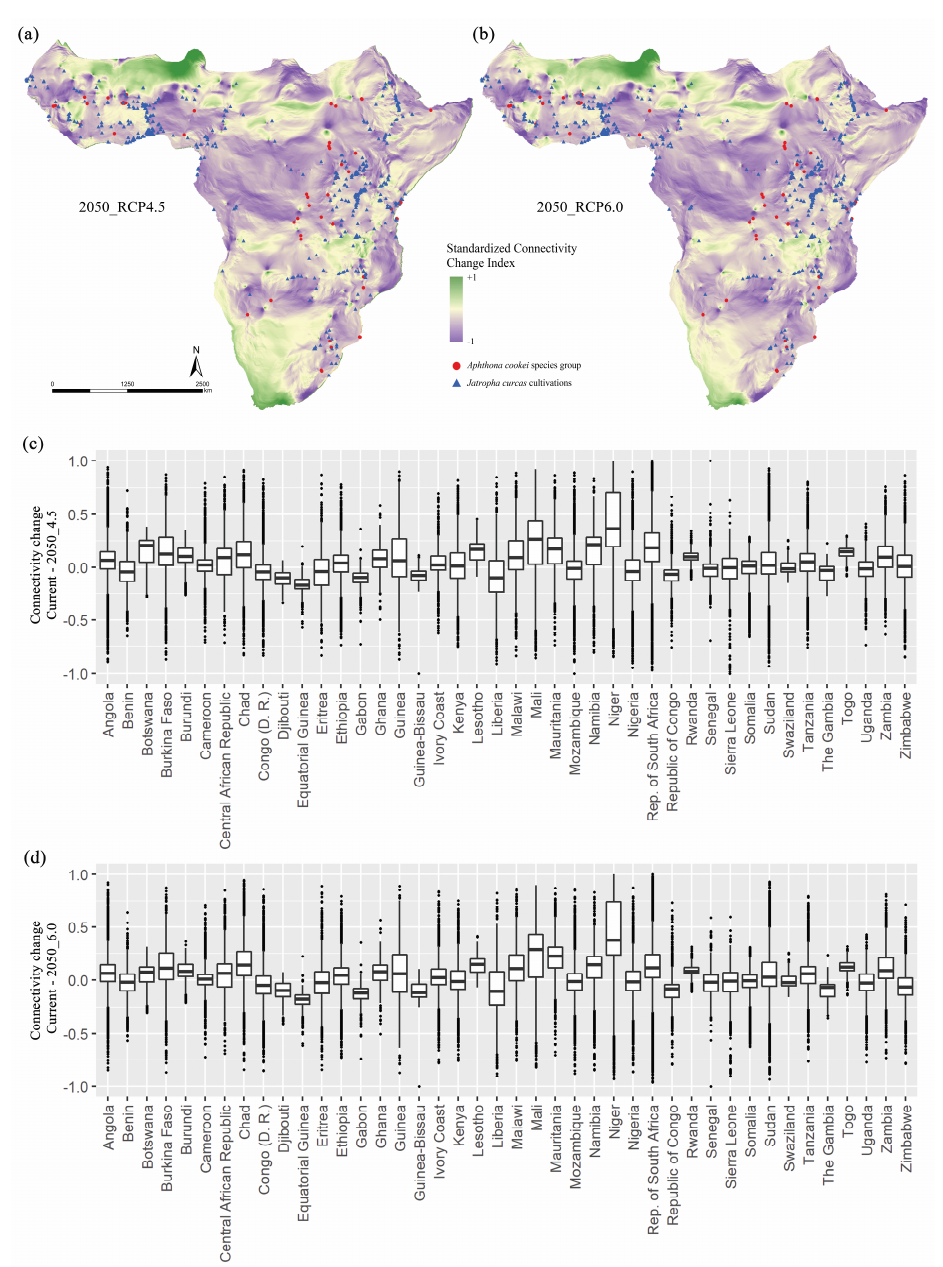
Figure 2. Changes in connectivity among Aphthona cookei species complex populations and Jatropha curcas cultivations from current to future ( a ) 2050 RCP4.5 and ( b ) 2050 RCP6.0 climatic conditions, calculated through the standardized connectivity change index [26]; the corresponding values are also reported in boxplots for ( c ) 2050 RCP4.5 and ( d ) 2050